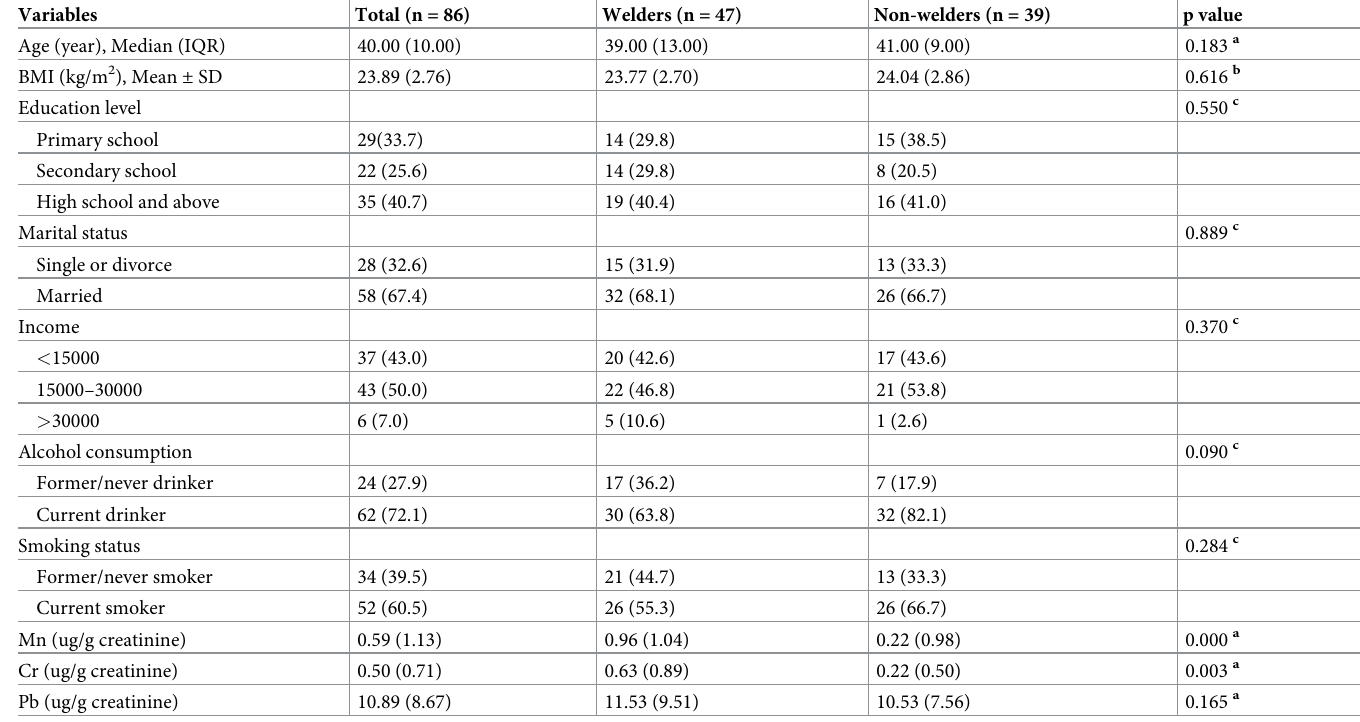
Table 1. Demographic characteristics of the welding fume exposed workers (n =